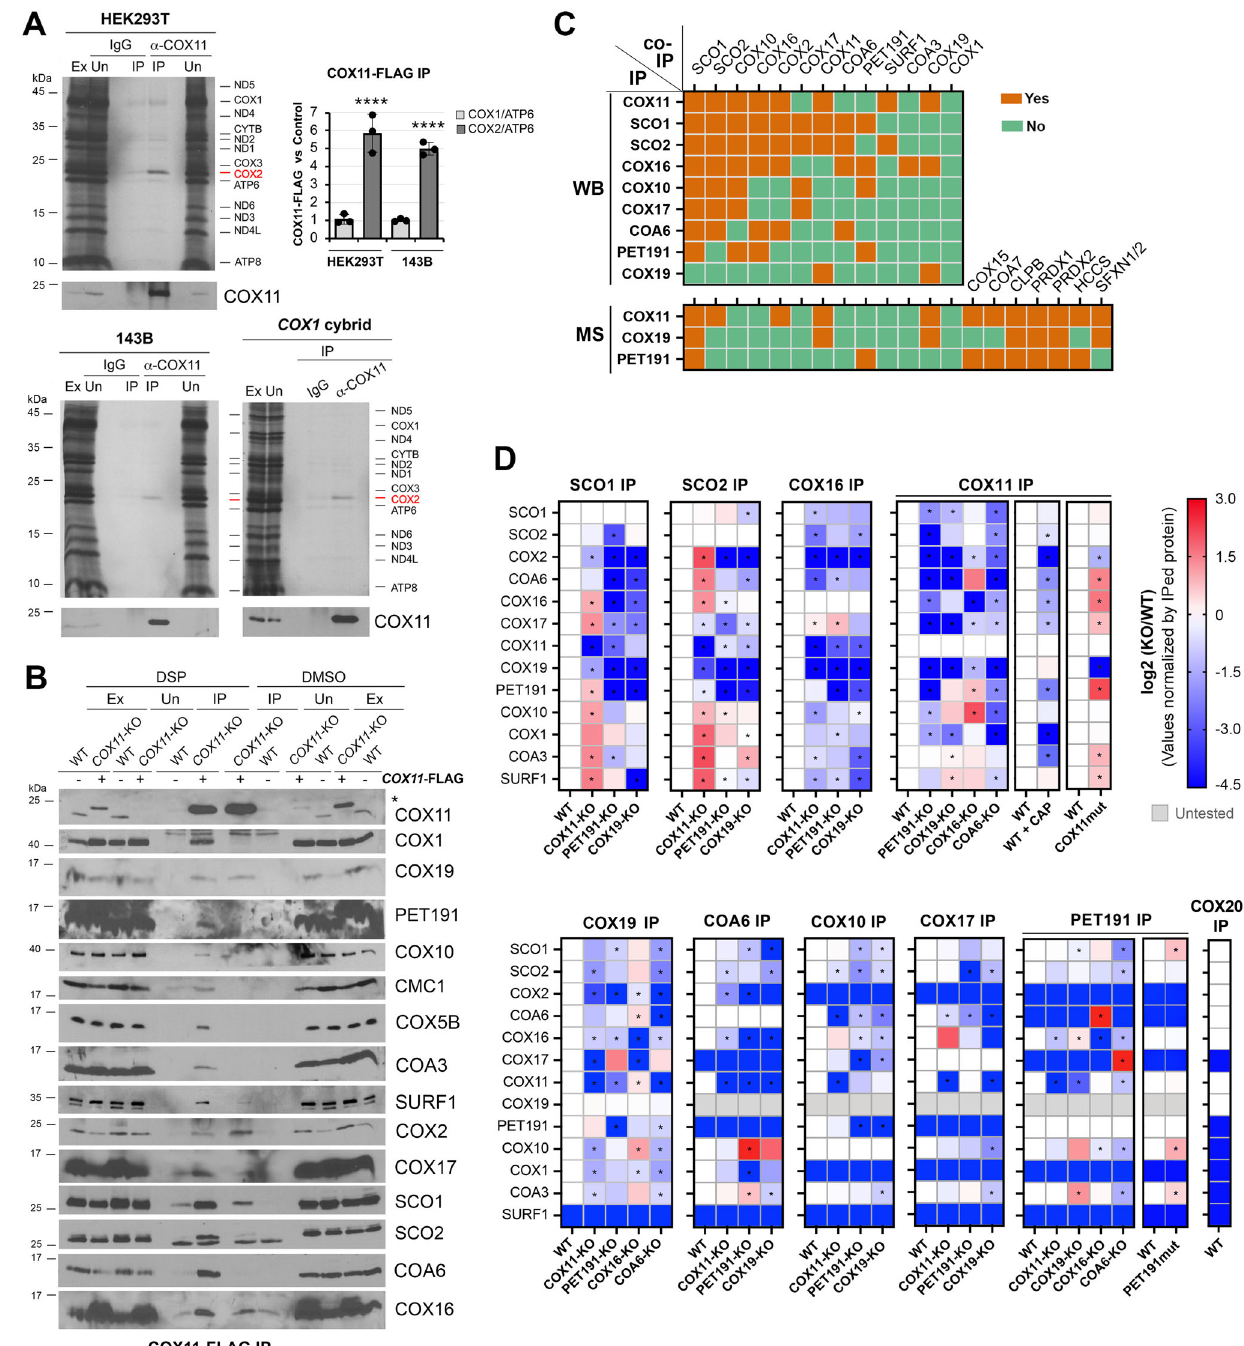
Fig. 3 CcO subunits and metallochaperones undergo stable and transient interactions to drive and coordinate metal center assembly. A Co- immunoprecipitation (co-IP) of endogenous COX11 with newly synthesized mitochondrial polypeptides, identi fi ed in the right-hand side. The graph shows the densitometry (average ± SD) of three independent experiments. Black dots represent individual data points. Two-sided unpaired t -test, **** p < 0.0001. The ratio “ α -COX11 IP signal vs. control background signal ” for two parameters, COX1/ATP6 and COX2/ATP6, is presented. B Co-IP of COX11-FLAG with CcO subunits and assembly factors in the presence or absence of the crosslinker DSP. Ex, extract; Un, unbound; IP, immunoprecipitate. C Stable interactions among CcO assembly factors determined by IP followed by either immunoblotting (WB) or mass spectrometry (MS). D Transient interactions among CcO assembly factors determined by IP in the presence of the crosslinker DSP (dithiobis(succinimidyl propionate)) or the vehicle DMSO (dimethyl sulfoxide) followed by immunoblotting. The heat maps show the average quanti fi cation of three independent experiments. Two-sided unpaired t -test. * p < 0.05. Figures A , B are representative of three independent repetitions with similar results. Source data for A , B , D are provided as a Source Data fi le.